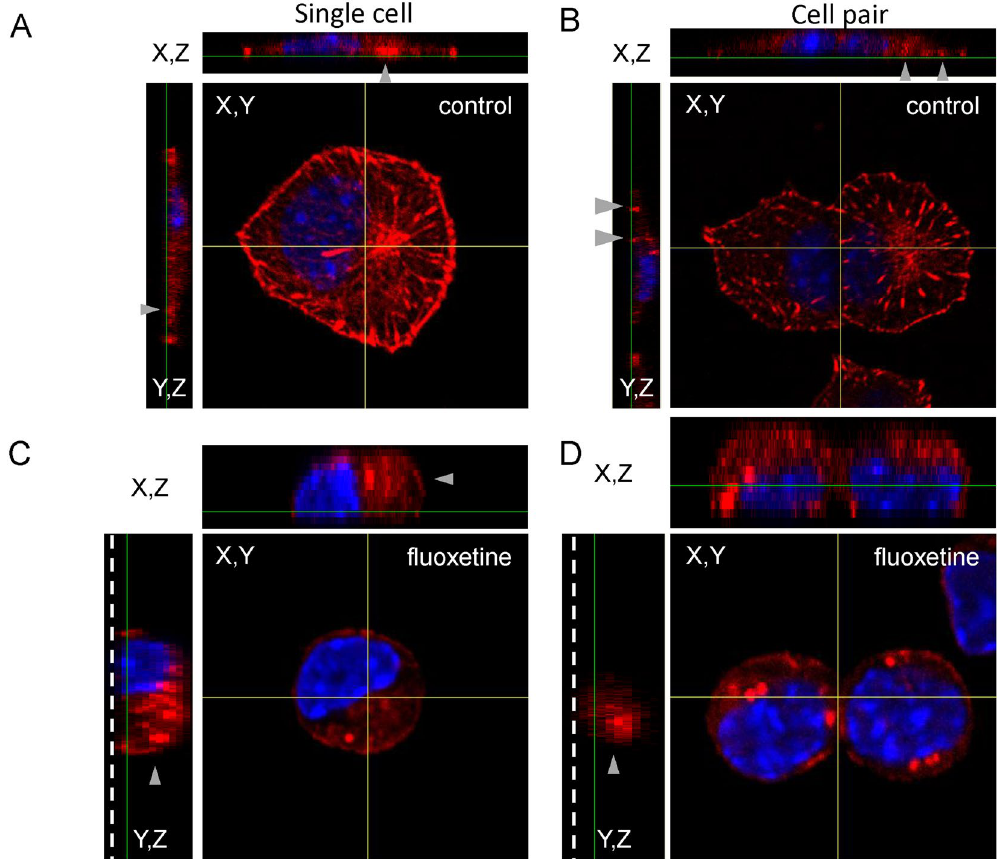
Figure 6. Fluoxetine alters the structure of actin filaments from MIN6 cells attached to E-cad/Fc. MIN6 cells were seeded on glass slides coated with E-cad/Fc for 6 h, and then treated with or without fluoxetine (30 μ M) for 3 h. Cells were fixed and then stained with phalloidin-TRITC (red) and Hoechst 33258 (blue). In confocal image, yellow lines indicate the orientation of z-sections. The upper panel represents the x-z sections across the horizontal line. The left panel represents the y-z sections across the vertical line. The gray arrow head indicates the clustering and extension of actin filament. ( A ) Image of control single cell. ( B ) Image of control cell pair. ( C ) Image of fluoxetine-treated single cell. ( D ) Image of fluoxetine-treated cell